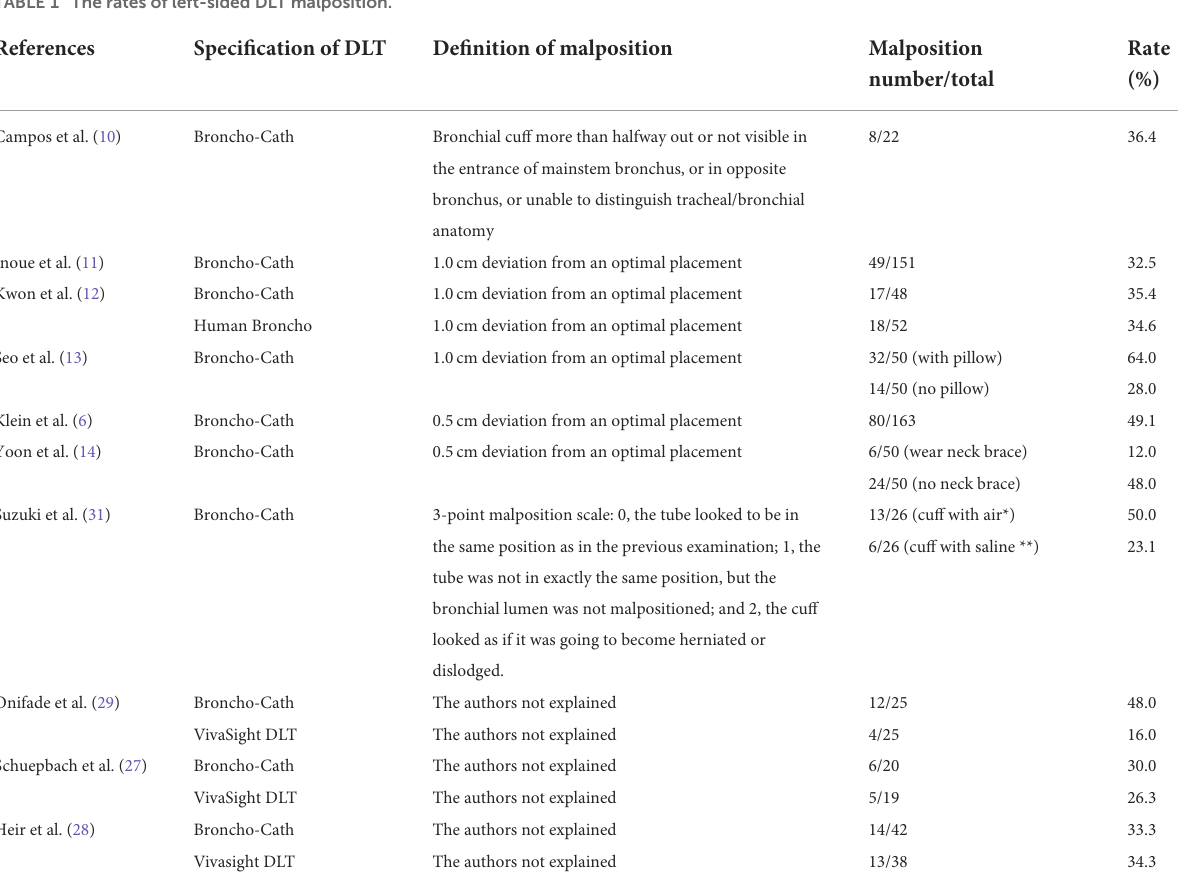
TABLE 1 The rates of left-sided DLT